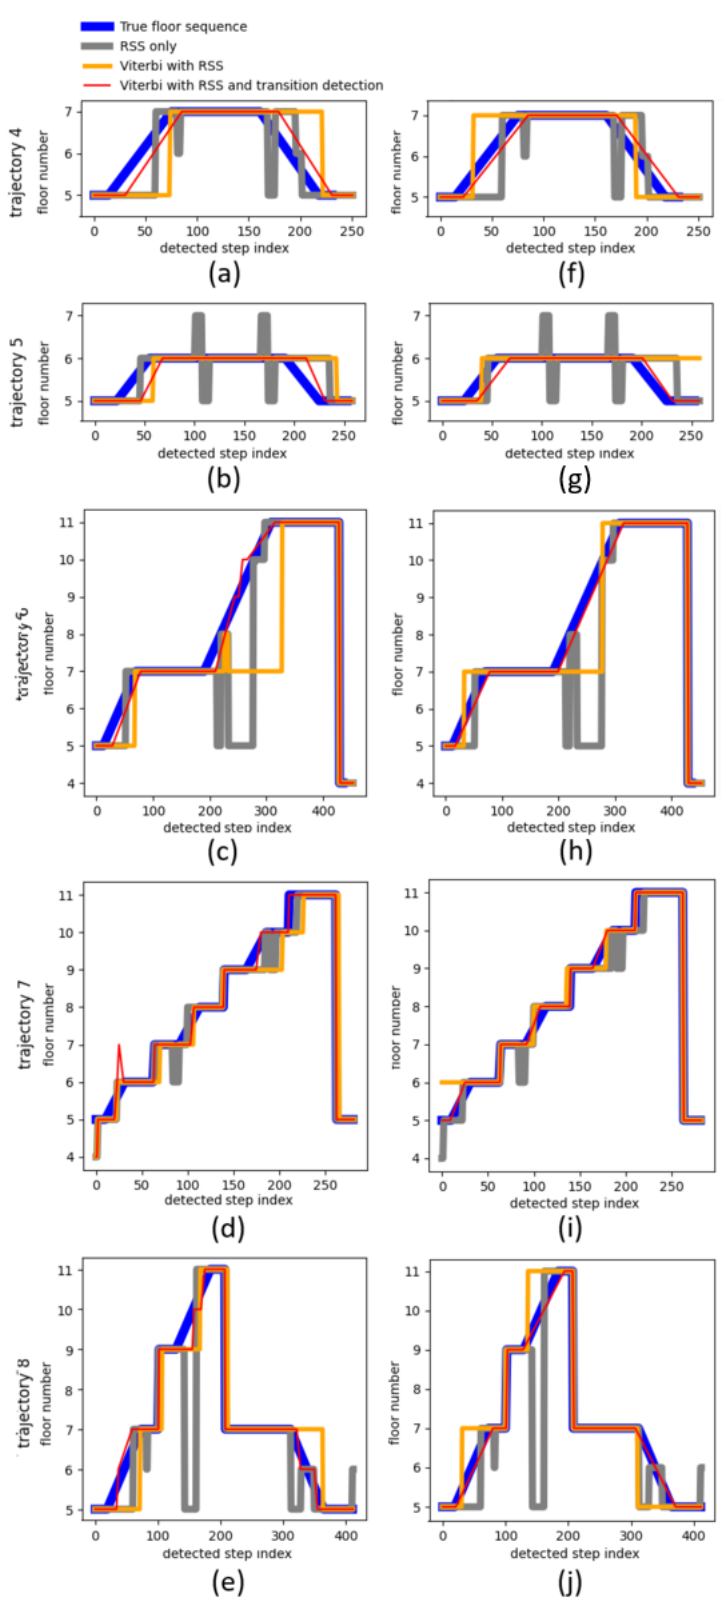
Figure 9. Plots of the estimated floor number as a function of the detected step index for variations of the floor number detection algorithm. ( a – e ) shows the real-time output for one iteration of each multifloor trajectory. ( f – j ) shows the batch output for the same iteration of the corresponding